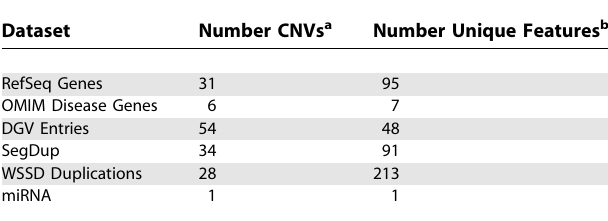
Table 12. Copy Number Variants Identified on the HuRef Sample